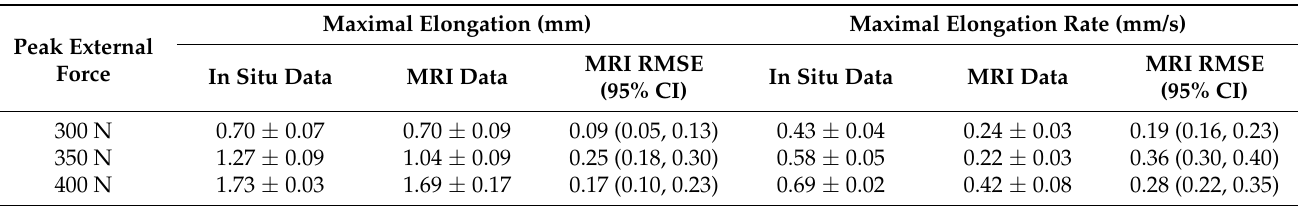
Table 1. Comparison of in situ and MRI-based measurements of maximal ACL elongations and elongation rates. Peak